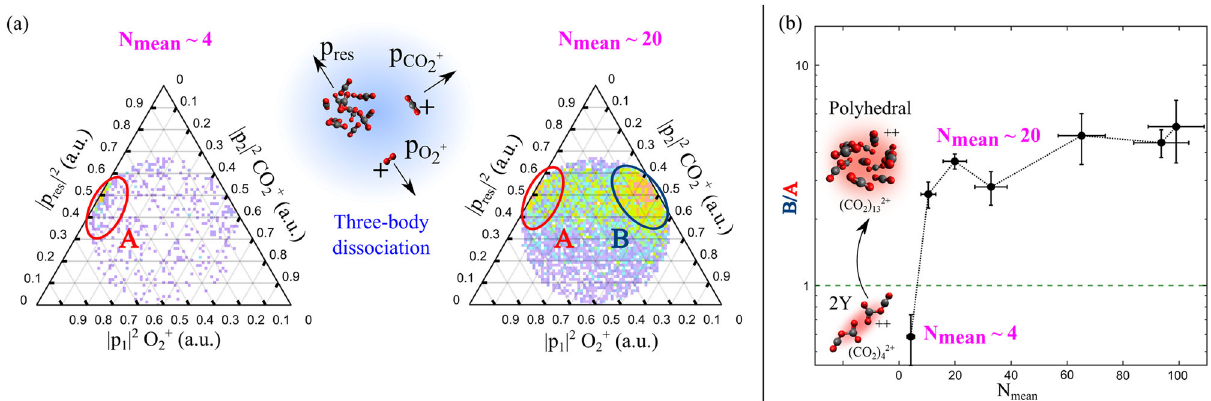
Fig. 2 Sequential cluster dissociation processes forming O þ momentum distribution between the fragments in the O þ three-body dissociation of the mother cluster into O þ distribution labelled region A (in red, left-hand side of Dalitz plot), for larger cluster sizes a second distribution labelled region B (in blue) appears to the right. b The cluster-size dependence of the intensity ratio between region A and region B from the O þ are calculated as described in Harnes et al 65 . The geometry of the doubly-charged cluster evolves from a 2Y-structure for small clusters to a polyhedral structure for cluster sizes above 11.